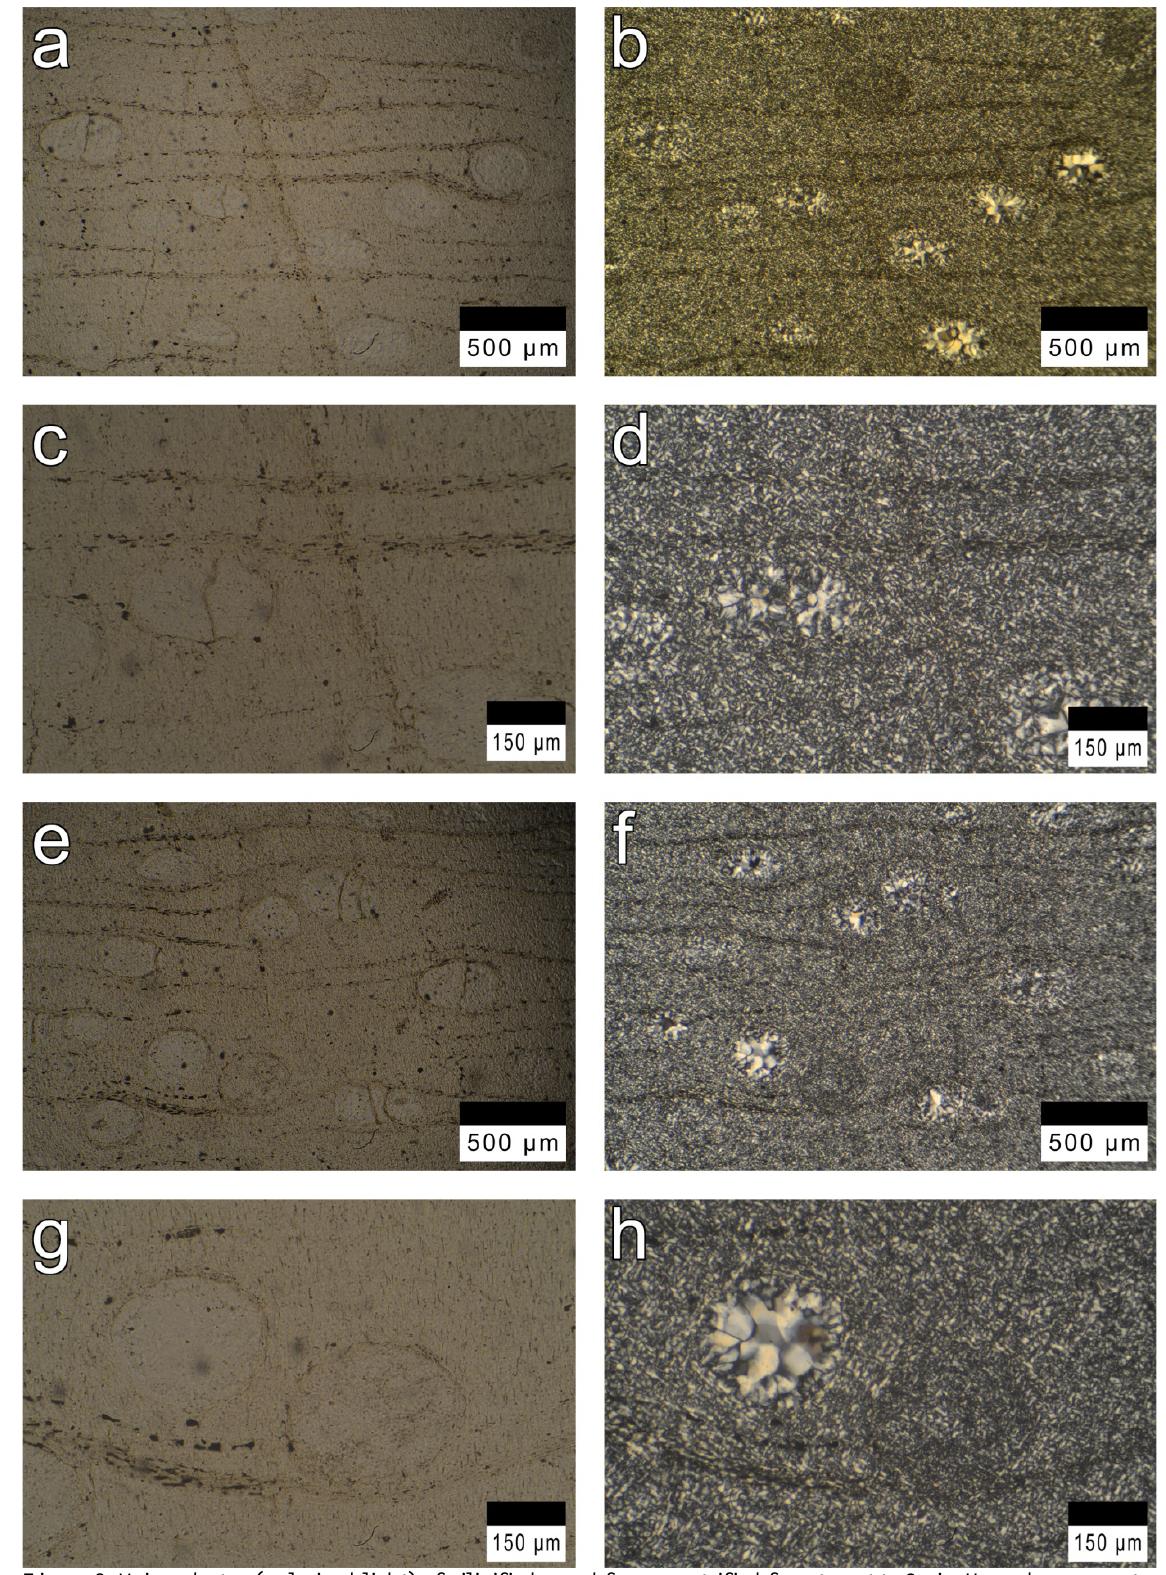
Figure 8. Microphotos (polarized light) of silicified wood from a petrified forest next to Ociu, Hunedoara county. Left side, one polarizer (1P). Right side, the same with crossed polarizers (+P). The 1P images show the structure of the wood. The +P images show that the material is comprised almost completely of microcrystalline quartz with a few spaces filled in with microfibrous